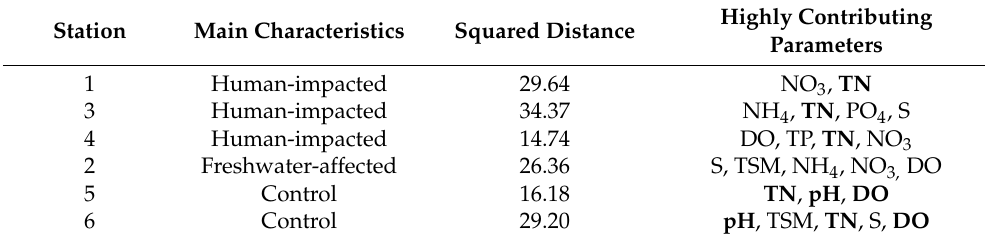
Table 2. Outputs of SIMPER analysis showing, in a decreasing order, the percentage contribution of each parameter to the within-groups similarity. The parameters shared as highly contributing drivers are reported in